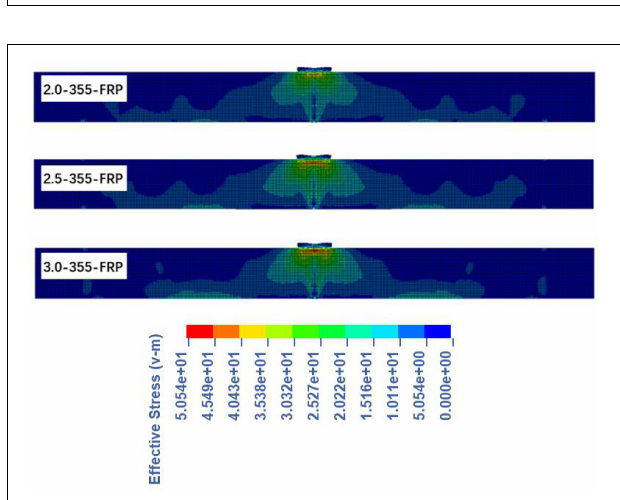
FIGURE 9 | Equivalent Stress field of reinforced beams under different impact heights.